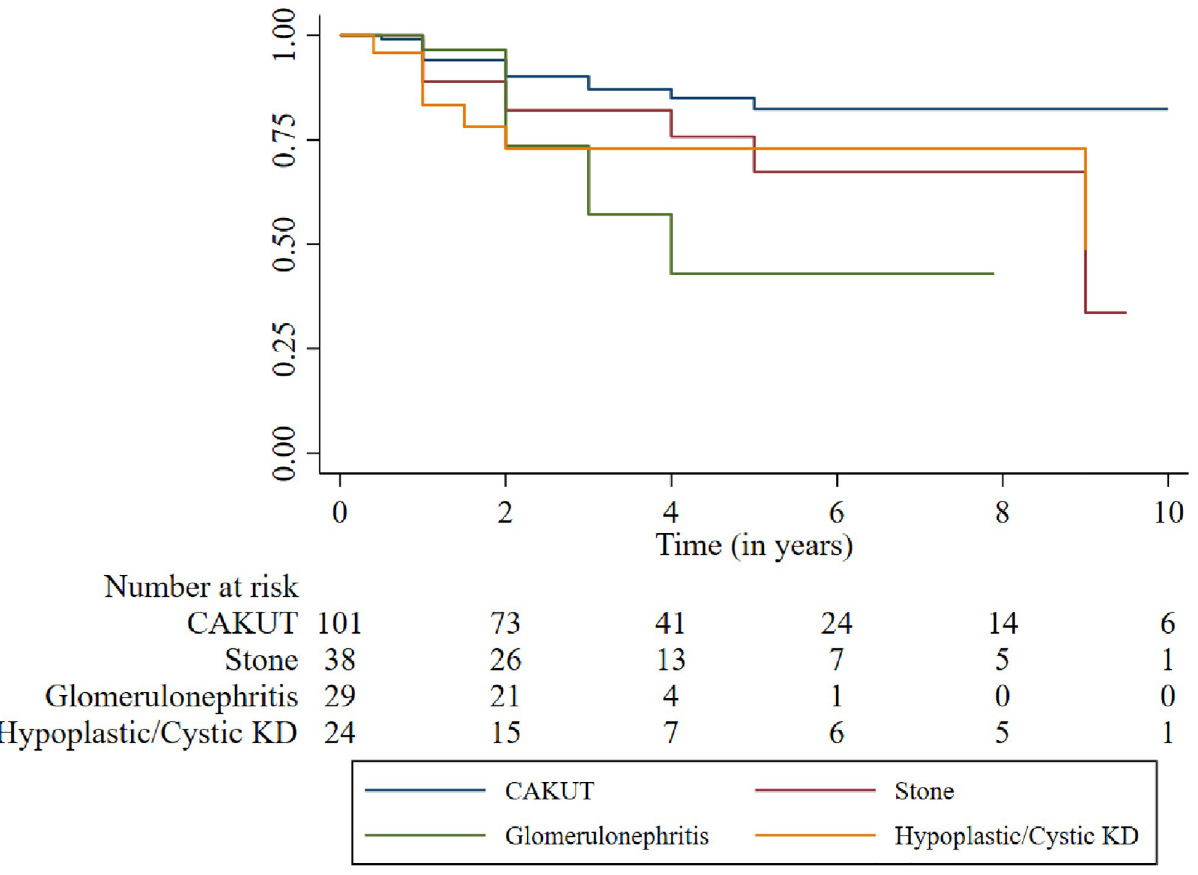
Fig 2. Survival curves for each underlying disease category in the cohort.